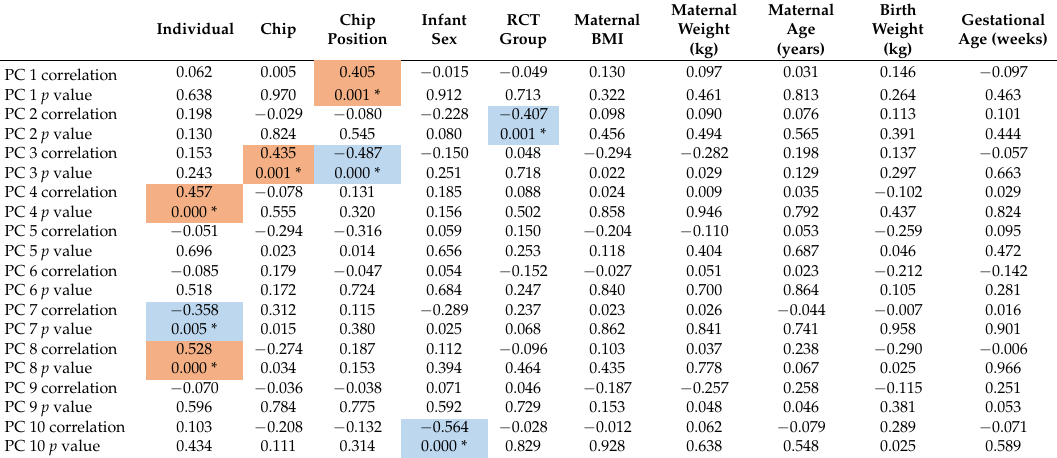
Table displaying correlation coefficients, directions of correlation, and p -values between principal components and various clinical parameters. Shaded boxes indicate direction of significant correlations between principal components and clinical parameters (orange: positive correlations, blue: negative correlation). Correlation coefficients were calculated using Pearson correlations. PC: Principal Component, RCT: Randomised Controlled Trial * Significant at p <